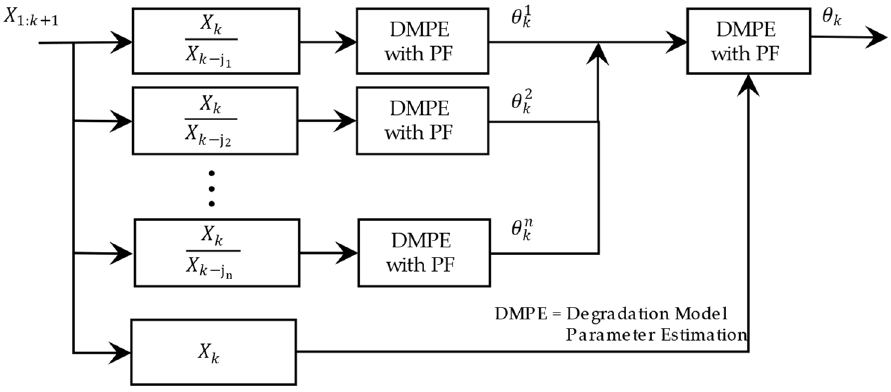
Figure 7. Flow of multi-step online parameter estimation.